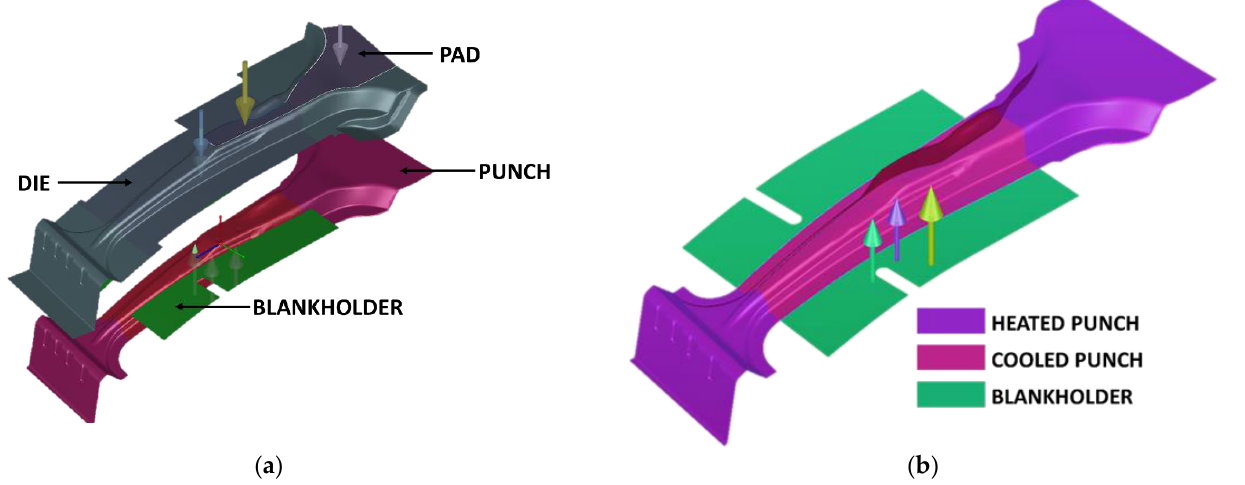
Figure 3. ( a ) Forming tools modeled in AutoForm; ( b ) Punch modeled in heated and cooled parts.